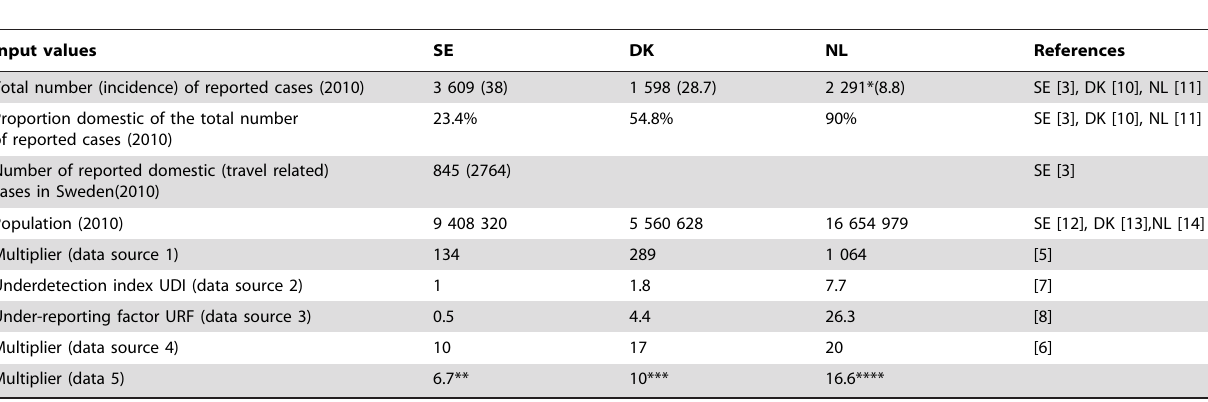
Table 1. Input values used to estimate the expected change in the number and incidence (cases/100 000 inhabitants) of reported domestic human salmonella cases in Sweden in 2010 in the different